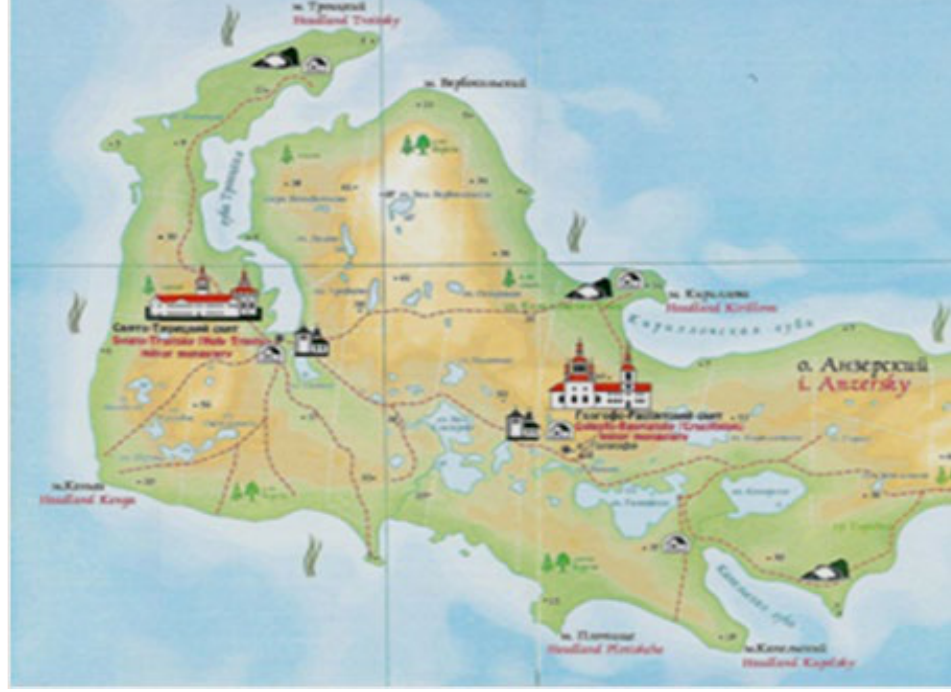
Figure 5. – Solovki. Anzer Island. Mount Golgotha